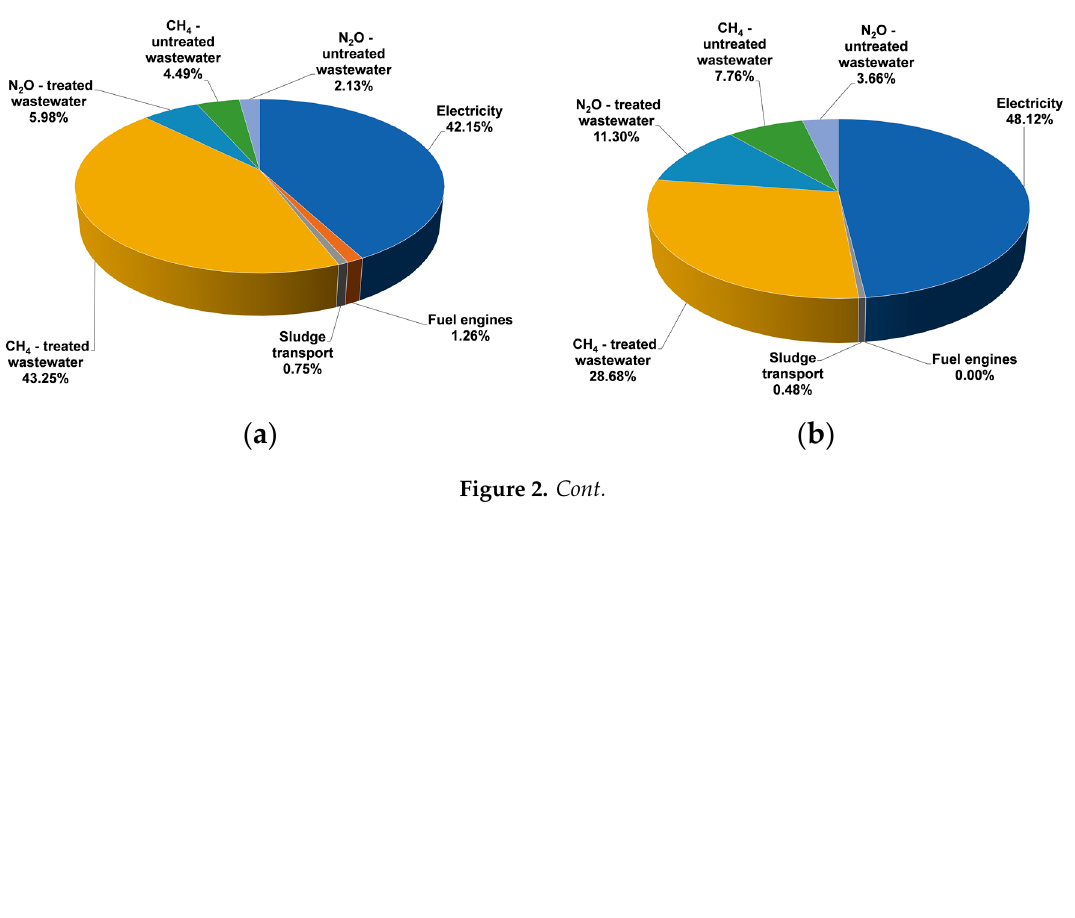
Table 4. Service level indicators.